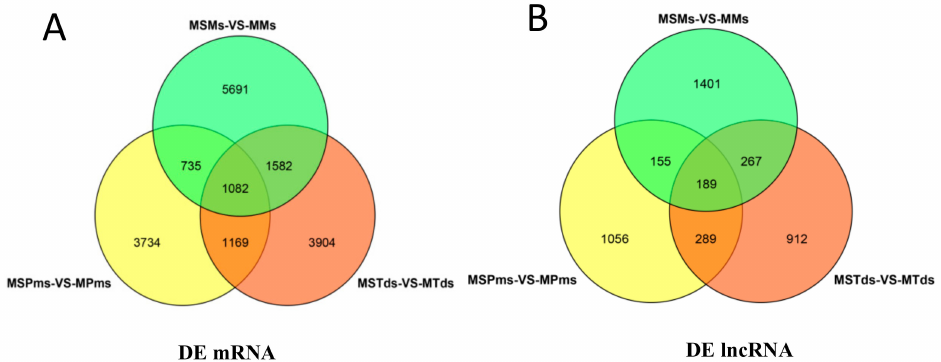
Figure 2. Venn diagram showing known mRNAs corresponding to di ff erentially expressed genes (DEGs), and novel lncRNAs di ff erentially expressed at three stages of anther development, between the cytoplasmic male sterility line C2P5A and the maintainer line C2P5B. ( A ) Venn diagram of known mRNAs of DEGs. ( B ) Venn diagram of novel lncRNA DEGs. MS—Male sterility line; M—Maintainer line; Pms—pollen mother cell stage; Tds—tetrad stage; Ms—mononuclear